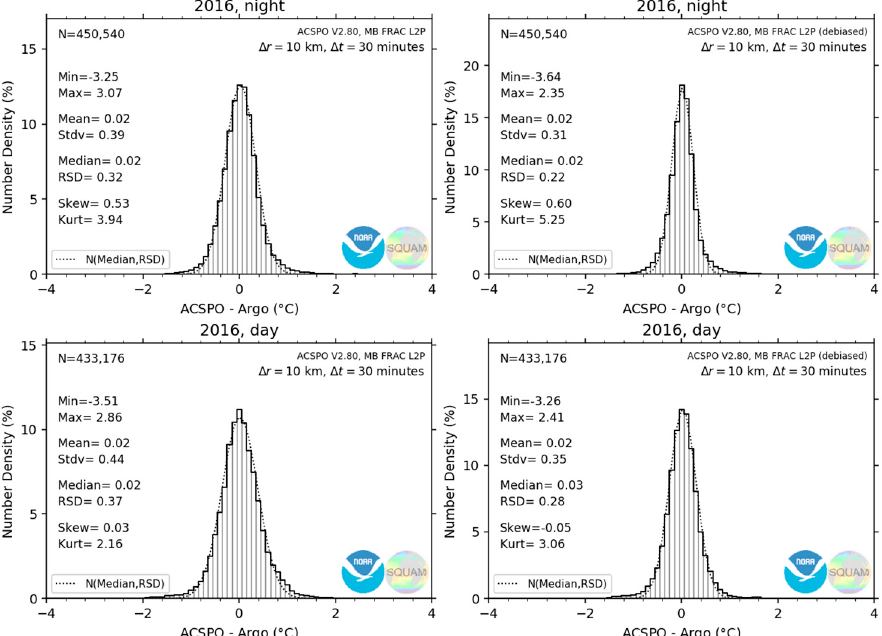
Figure 11. Same as in Figure 8 but against AFs.